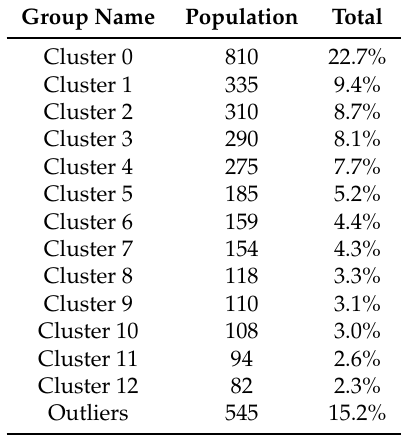
Table 7. Dynamic Hypertension sub-population